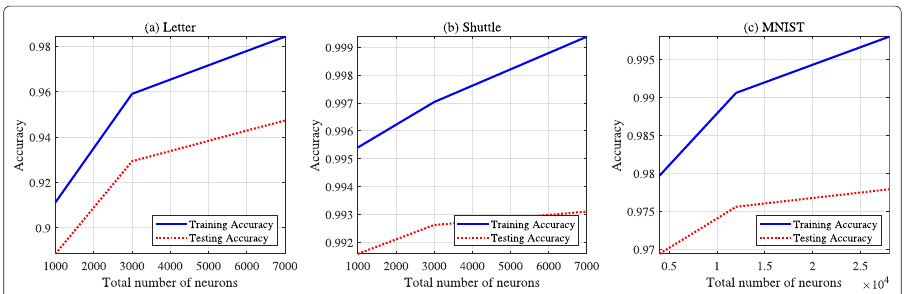
Fig. 4 Training and testing accuracy against size of HNF using ELM feature vector in the first layer and DCT in the next layers. Size of an L -layer HNF is represented by the number of nodes, counted as n ( 1 ) + Here, L = 3 for all three datasets. The number of nodes in the first layer ( n ( 1 ) ) is set according to Table 2 for each